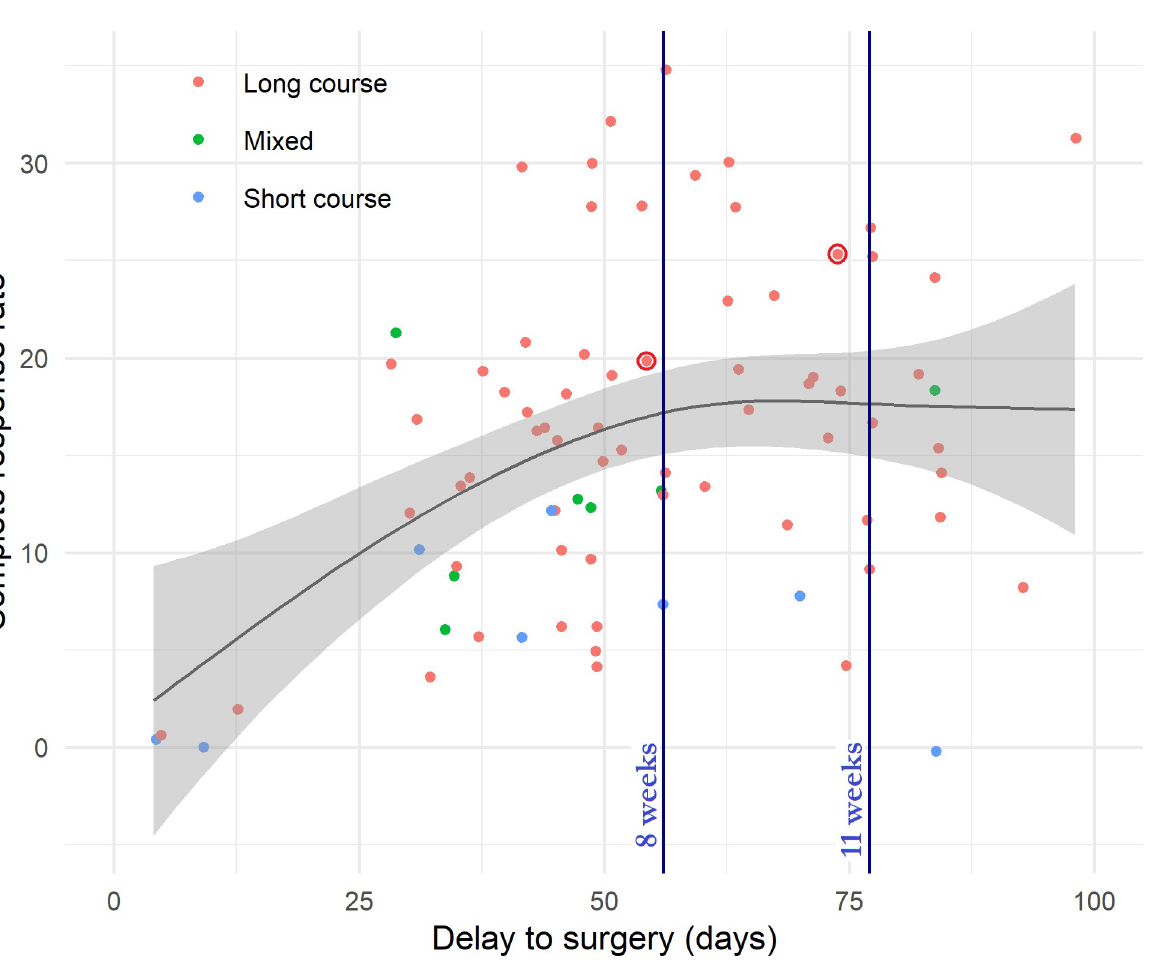
Fig 3. Influence of delay to surgery on complete pathological response. Delay to surgery (from completion of neoadjuvant therapy) plotted against rate of complete pathological response in 39 reviewed studies (27379 patients), coloured by included radiotherapy courses. Long course- only studies ( > 24 fractions) are coloured in red, short course-only studies coloured in blue, and studies including all fractionation schedules coloured in green. Data from the present study are indicated by red circles. Data points are fitted to a generalised additive model as implemented in R and this model is plotted as a trend line, with shaded areas indicating confidence